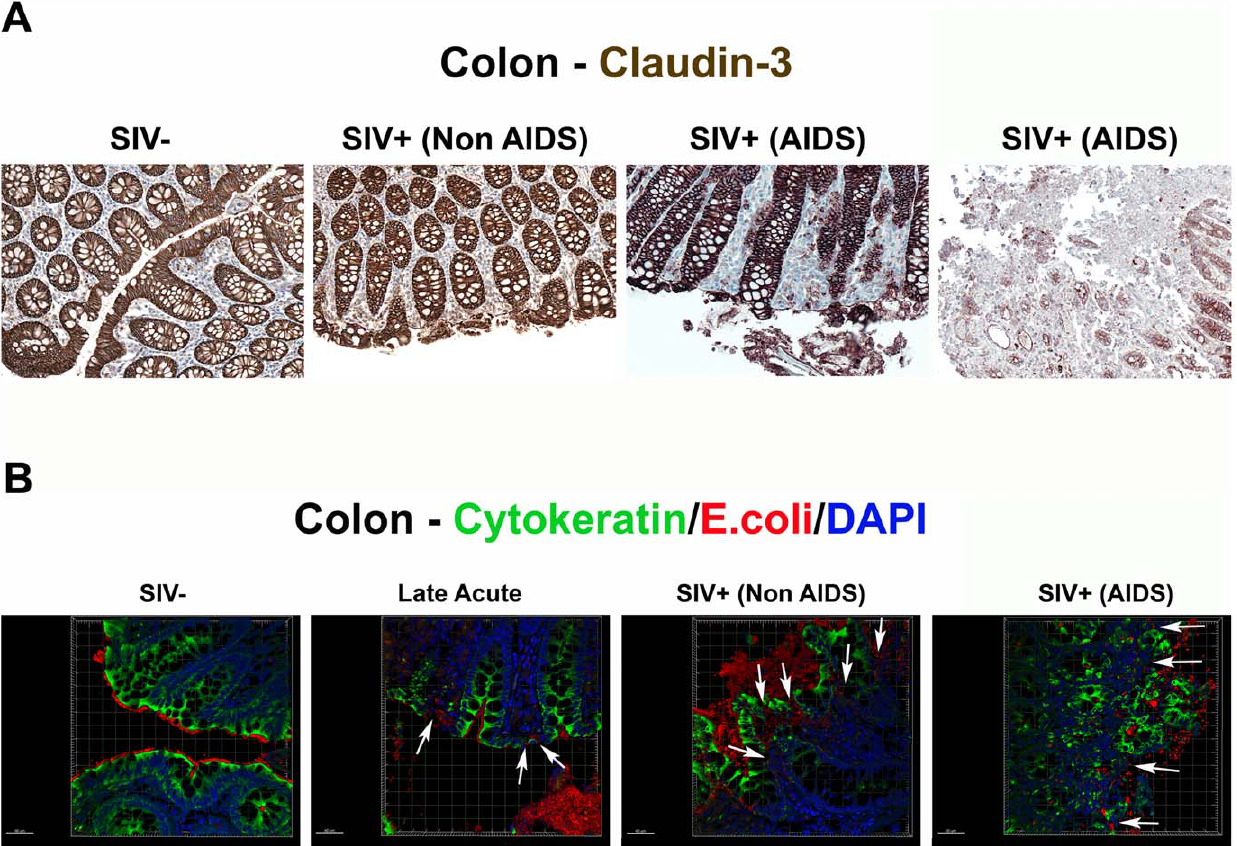
Figure 7. Damage to the integrity of the epithelial barrier is associated with infiltration of microbial products into the lamina propria. ( A ) Representative images (200 6 ) of colon stained for the tight junction protein claudin-3 (brown) as a marker for intact epithelial barrier. Note the multifocal regions of the epithelial barrier that are missing in SIV + RMs, allowing direct contact of luminal contents with the LP. ( B ) Confocal immunofluorescent 3-D images of colon (400 6 ) stained for cytokeratin (epithelial cells; green), E. coli (red) and DAPI (nuclei; blue). Discontinuities in the epithelial barrier allowing translocation of microbial products into the LP are present in late acute SIV + RMs (14 dpi) and progressively more severe in chronic Non-AIDS and chronic AIDS RMs (white arrows point to epithelial discontinuities and translocated microbial products). Scale bars =40 m